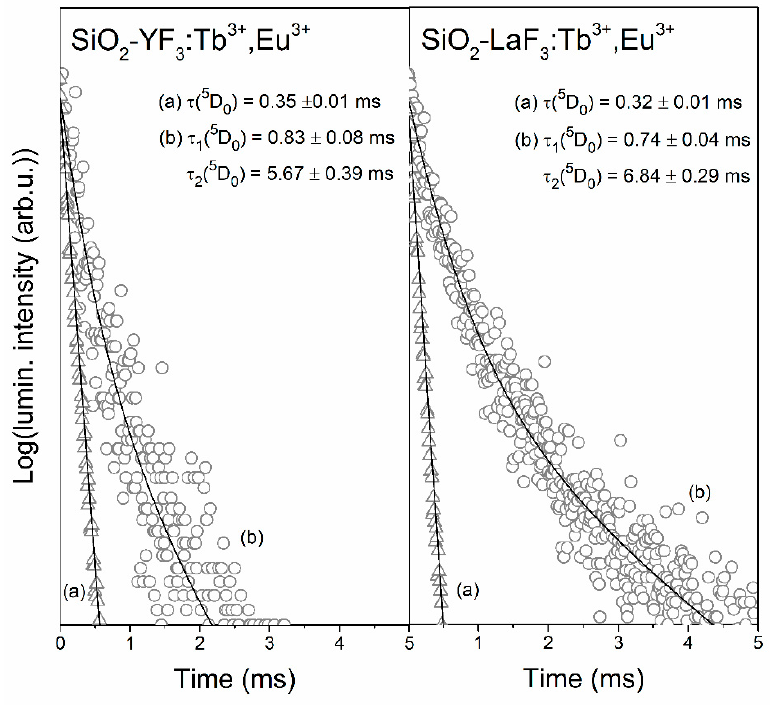
Figure 11. Luminescence decay curves of the 5 D 0 state of Eu 3+ recorded for xerogels ( a ) and glass- glass-ceramics ( b ) co-doped with Tb 3 + / Eu 3 + ceramics ( b ) co-doped with Tb 3+ /Eu 3+ ions. Table 3. Luminescence lifetimes of the 5 D 0 state of Eu 3+ and their contributions for fabricated glass- ceramics.